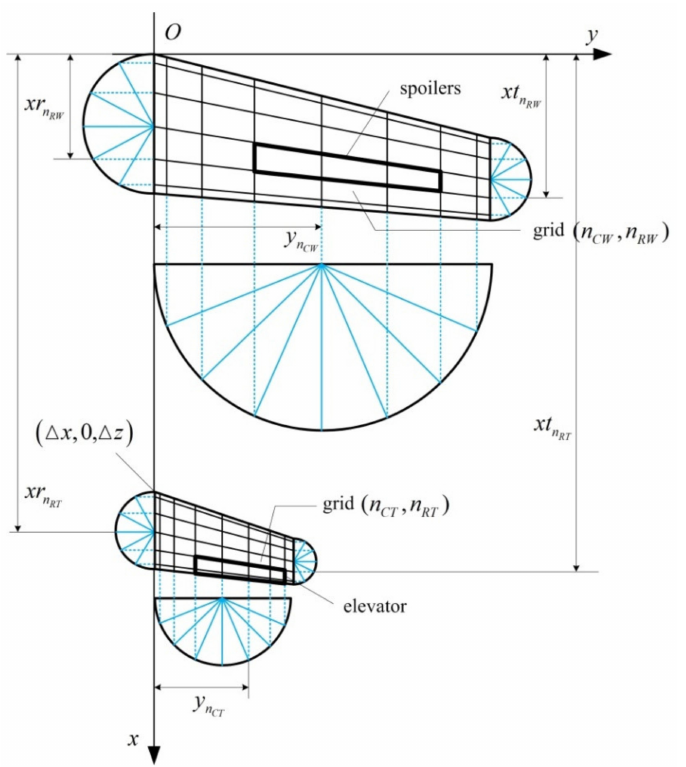
Figure A1. Grid distribution on wing and horizontal